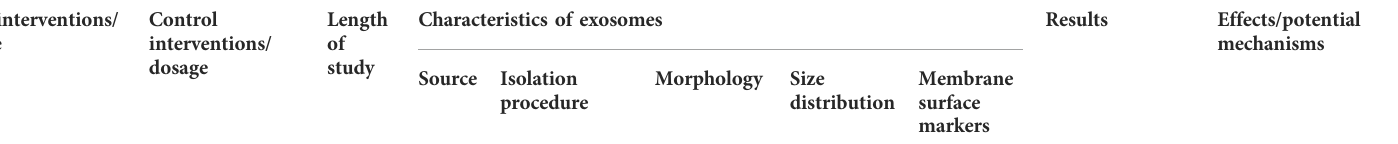
TABLE 1 ( Continued ) Exosomes modulators from TCM formulas on various